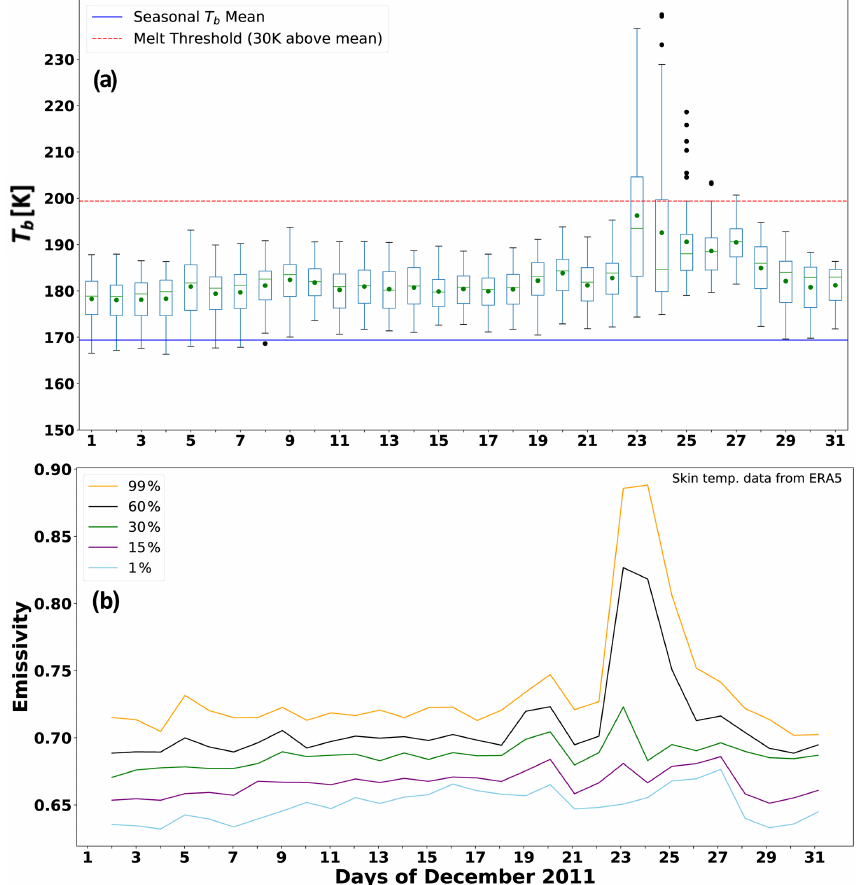
Figure 17. As in Fig. 3 but over the RIS region containing the Tom and Sabrina AWSs throughout December 2011. The five estimates of surface emissivity sampled in panel (b) from the region are referenced to the maximum T b value in the region on 23